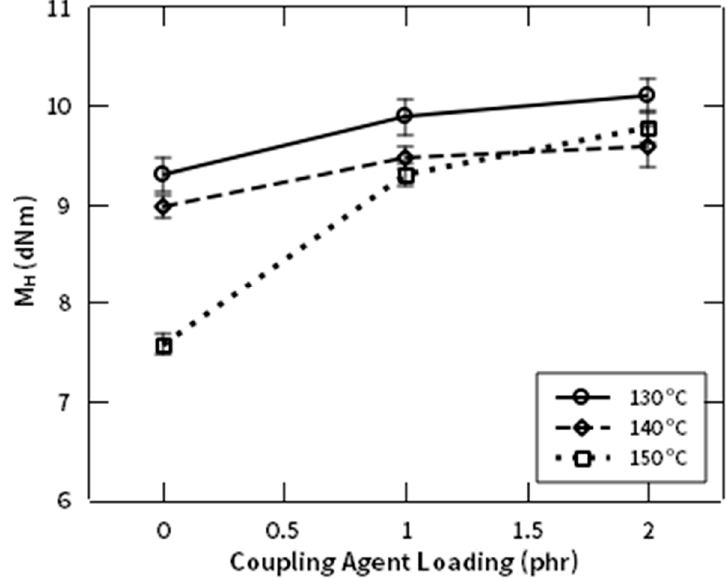
Figure 9. M H profile of NR compound at different composition of NR-g-St.